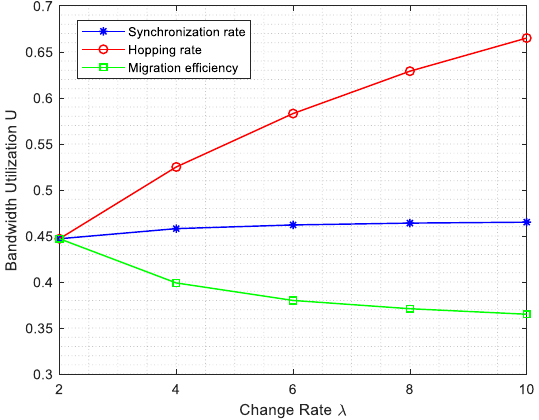
Figure 14. Effect of change rate on utilization of bandwidth.